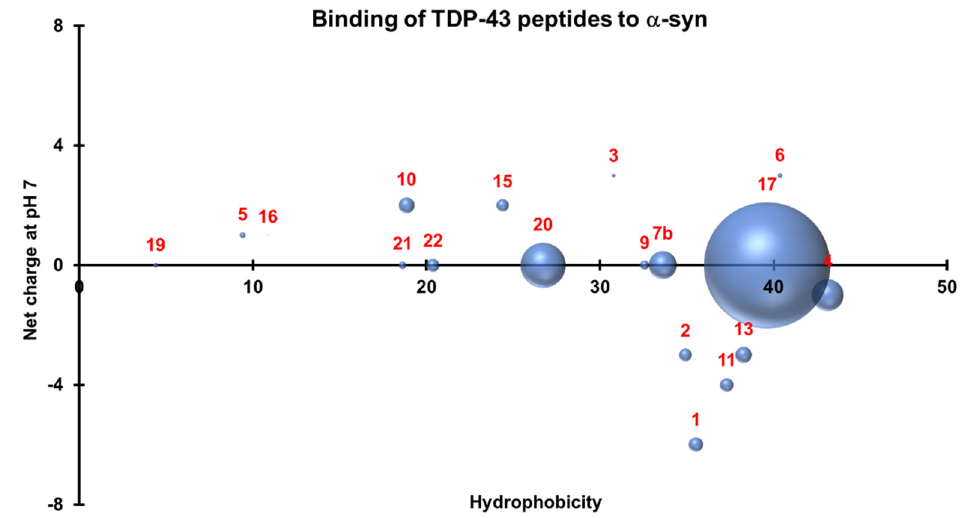
Figure 10. Three-dimensional scatterplot of TDP-43 peptides based on their hydrophobicity indices, net charge at pH 7.0, and their interactions with α -synuclein. Significant interactions occur with neutral peptides with hydrophobicity indices that fall within 20–40.